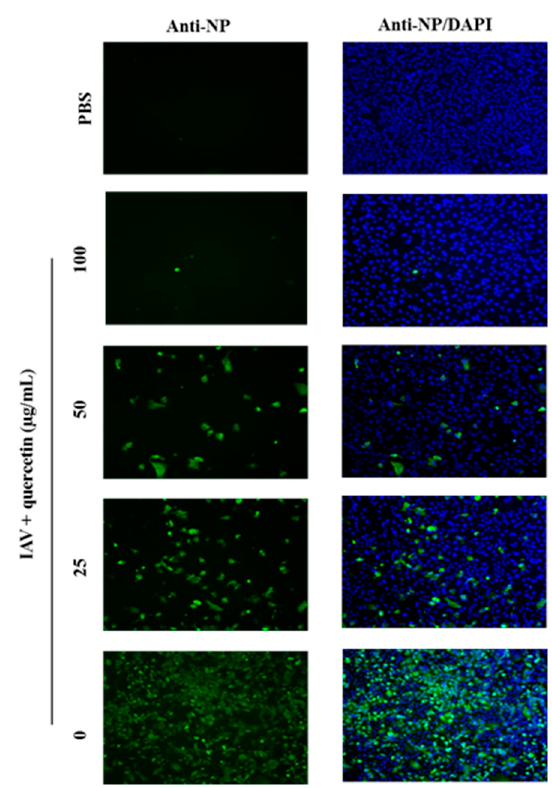
Figure 2. Quercetin inhibited vRNP localization in the nucleus. MDCK cells were infected with virus in the presence of quercetin at the concentration of 100, 50 and 25 μ g/mL. Viral NP protein was detected with NP-specific monoclonal antibody and Alexa 488-conjugated goat anti-mouse secondary antibody ( green ); the nuclei were counterstained with DAPI ( blue ). Original magnification, 40×.